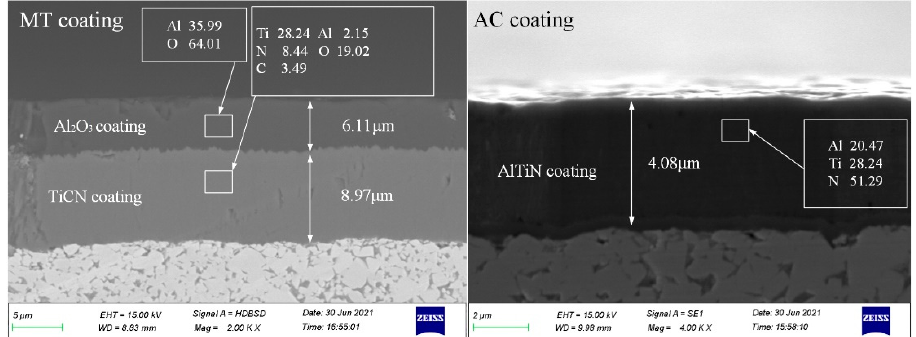
Figure 6. Thickness and composition of MT and AC coatings. Table 4. Compositions of different types of coatings.